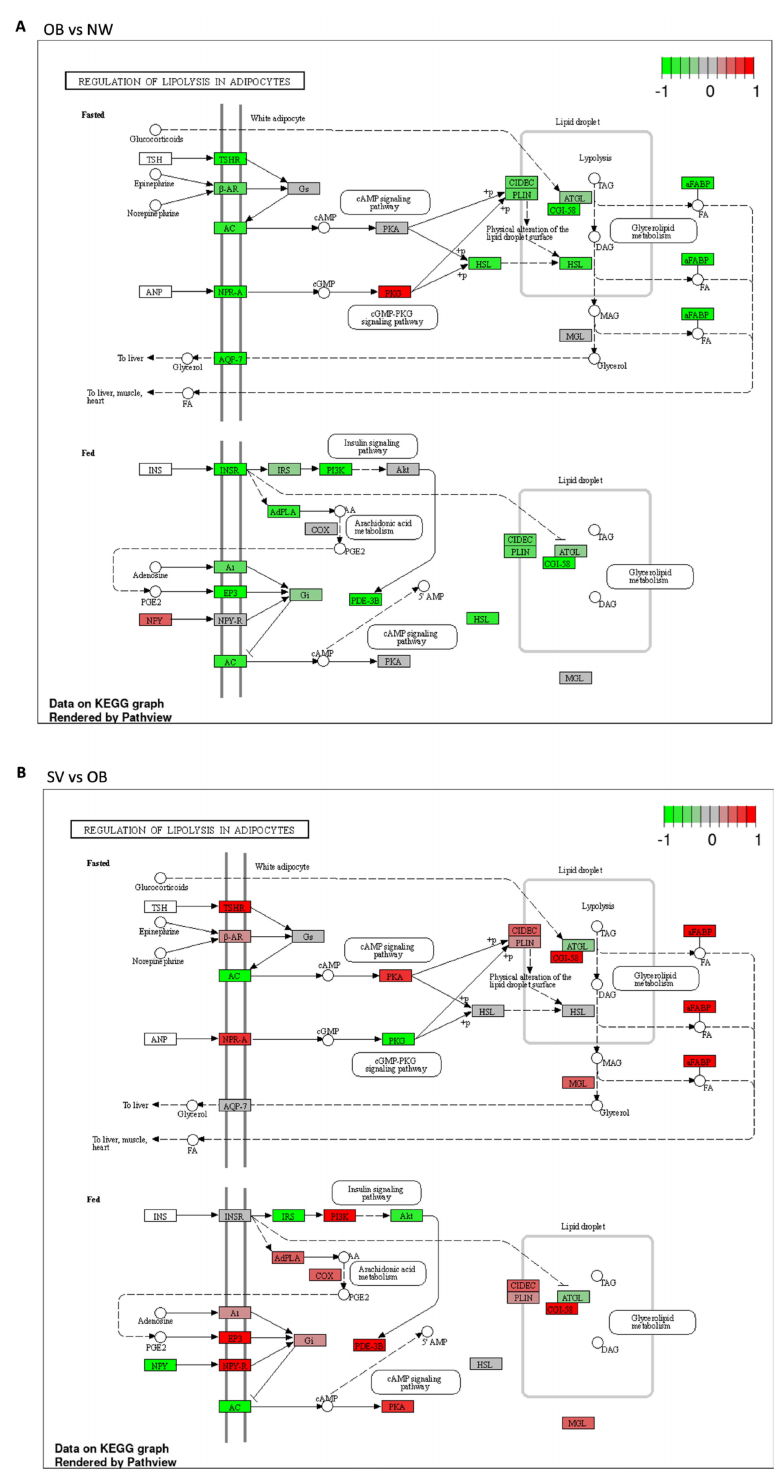
Figure 4. Regulation of lipolysis in adipocytes. ( A ): Schematic representation of the regulation of the lipolysis pathway between OB and NW. Most of the DEGs were downregulated, except for NPY and PKG, which were upregulated; ( B ): Schematic representation of the regulation of lipolysis in SV vs. OB, in which most of the DEGs were upregulated. Green boxes indicate downregulated genes; red boxed indicate upregulated genes; gray boxes indicate genes whose expression is not affected in these